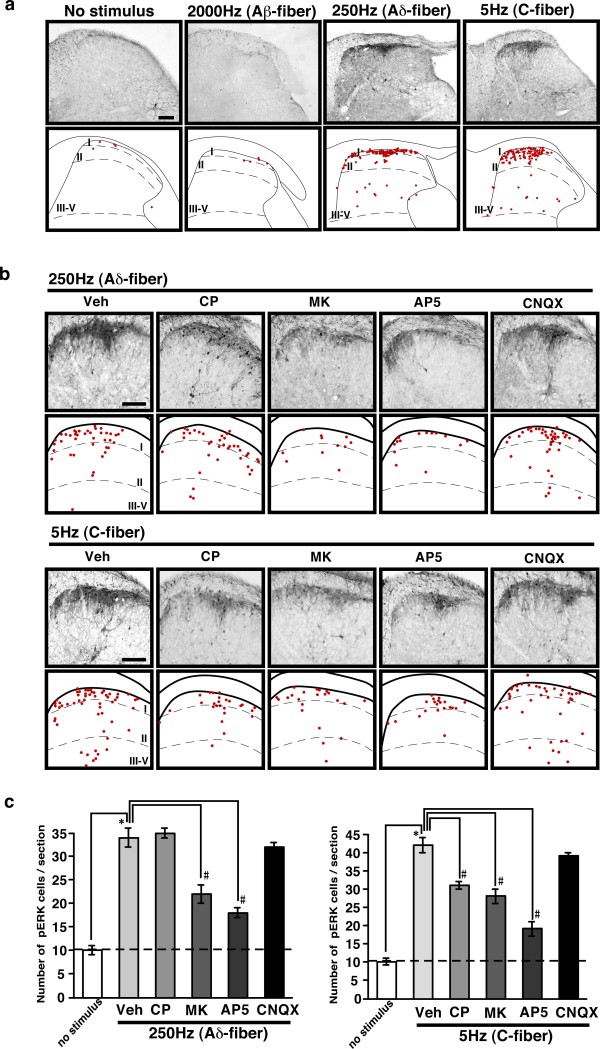
Pharmacological characterization of the activation of dorsal horn neurons by Aβ-, Aδ- and C-fiber electrical stimulations. The activation was evaluated by the immunoreactivity for pERK. (a) Representative pictures of pERK signals in the ipsilateral spinal dorsal horn after electrical stimulation to the right hind paw (see Methods). The figures in the bottom of each picture indicate pERK signals, which were used for pERK quantification (see Methods). Representative pictures of spinal antagonism of the pERK signals induced by 250 or 5 Hz stimuli (b), and the results of pERK quantification (c).: vehicle (Veh; aCSF), CP-99994 (CP) (10 nmol), MK-801 (MK) (30 nmol), AP-5 (30 nmol), CNQX (10 nmol). *: p < 0.05 vs. no stimulus, #: p < 0.05 vs. vehicle. Data represent the means ± S.E.M. from experiments using at least 4 mice. Scale bar = 100 μm.